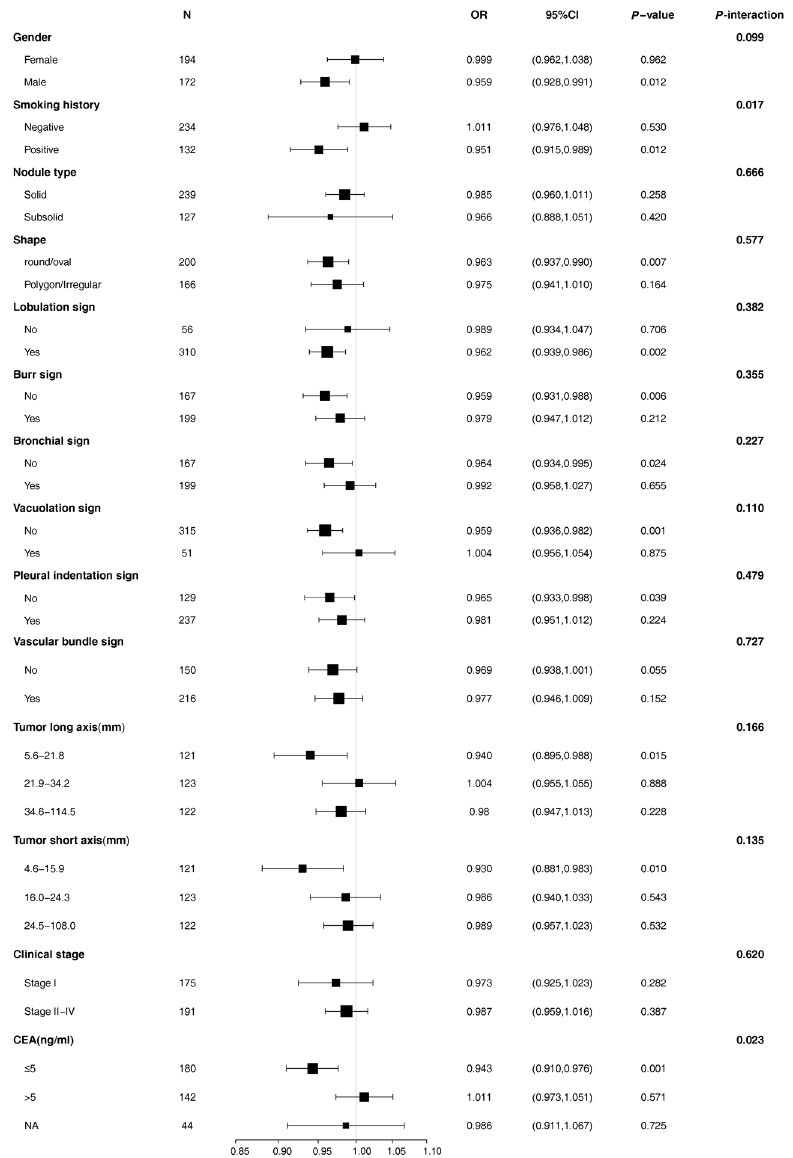
Figure 2. The stratification analysis of the association between SUV max and the probability of EGFR mutation (adjusted for age).